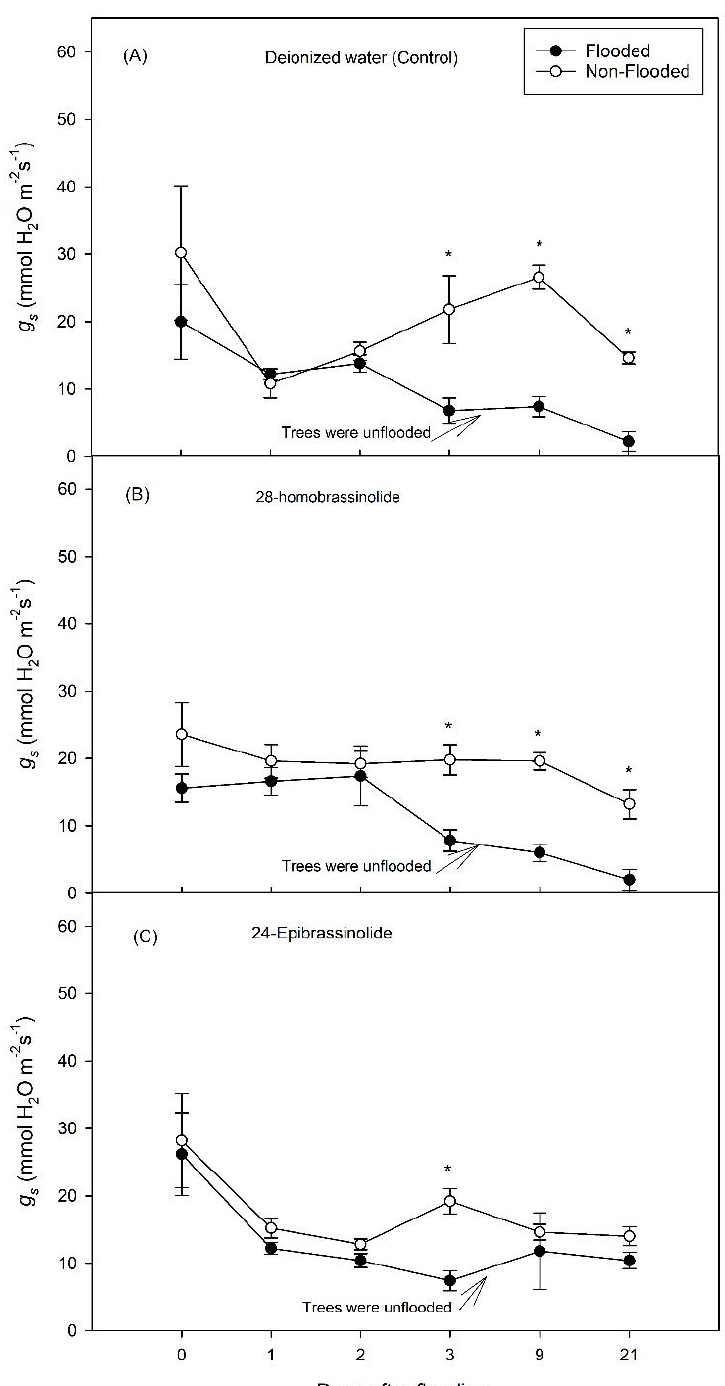
Figure 7. Effect of flooding on stomatal conductance ( g s ) of ‘Reed’ avocado trees treated with ( A ) deionized water as a control, ( B ) 28-homobrassinolide, or ( C ) 24-epibrassinolide, (Experiment 2). Symbols and bars indicate means ± std. err. Significant differences ( p ≤ 0.05) between flooding treatments are indicated with an asterisk and where determined by repeated-measures ANOVA. ‘Trees were unflooded’ indicates the day on which trees were removed from the flooding treatment to start the recovery period.